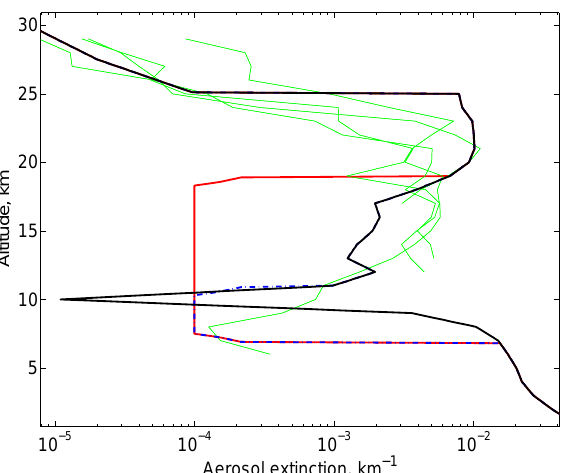
Fig. 15. The retrieved aerosol profile (black solid line), modifica- tions of the retrieved aerosol profile (solid red and dash-dotted blue) and SAGE II profiles (green lines).